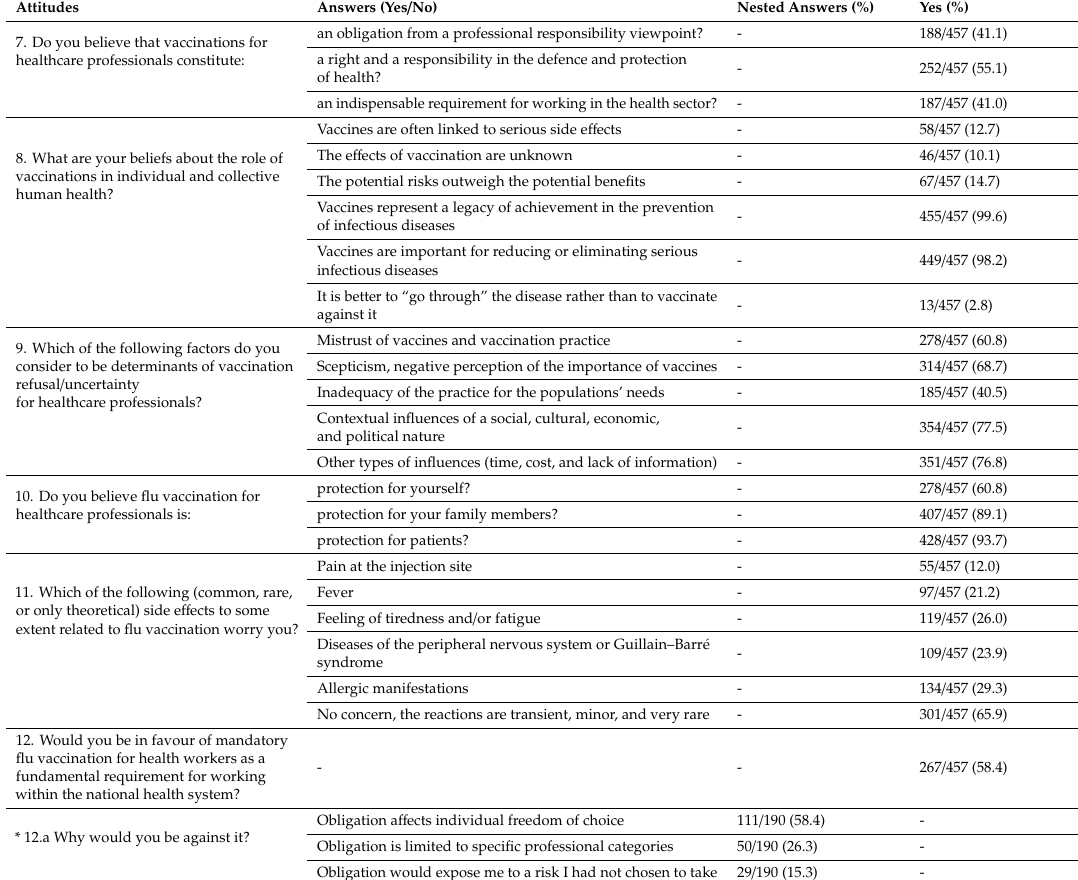
Table 2. Descriptive analysis of the variables inherent to the health workers’ general information, attitudes, behaviours, and knowledge. The first column on the left shows the questions of the questionnaire, while the possible answers (yes / no) are shown in the “answers”